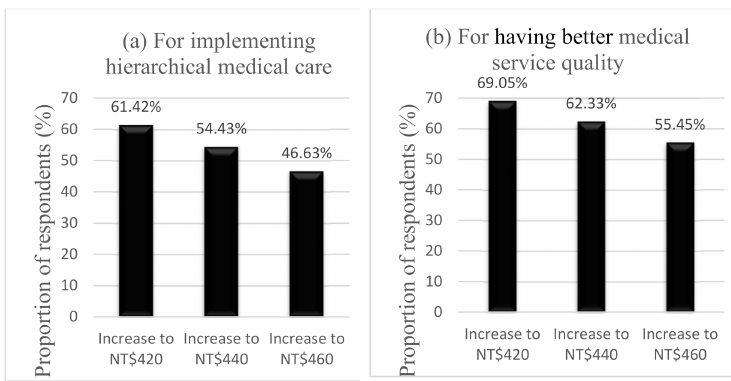
Figure 2. Proportion of respondents who would be willing to increase WTP.